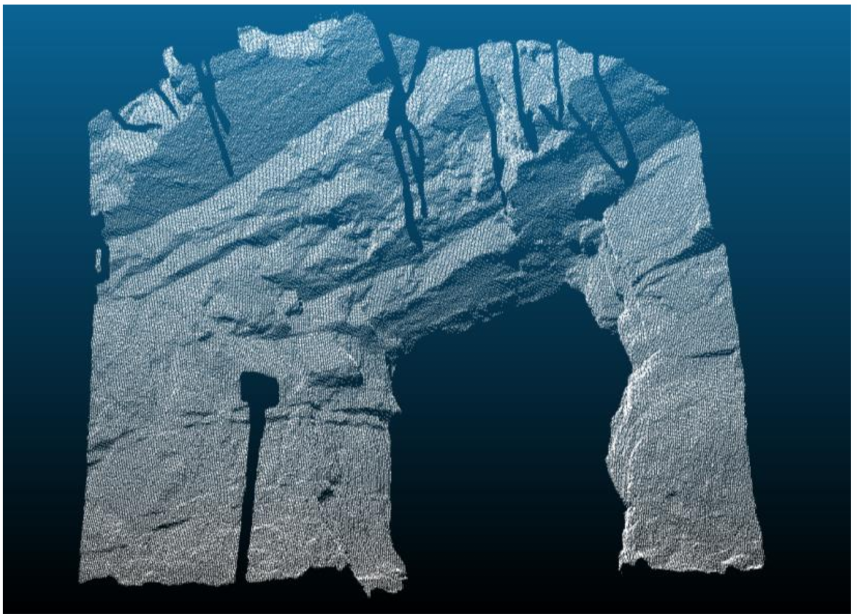
Figure 8. Point cloud acquired from scan position no. 4 used to search for discontinuity plans.